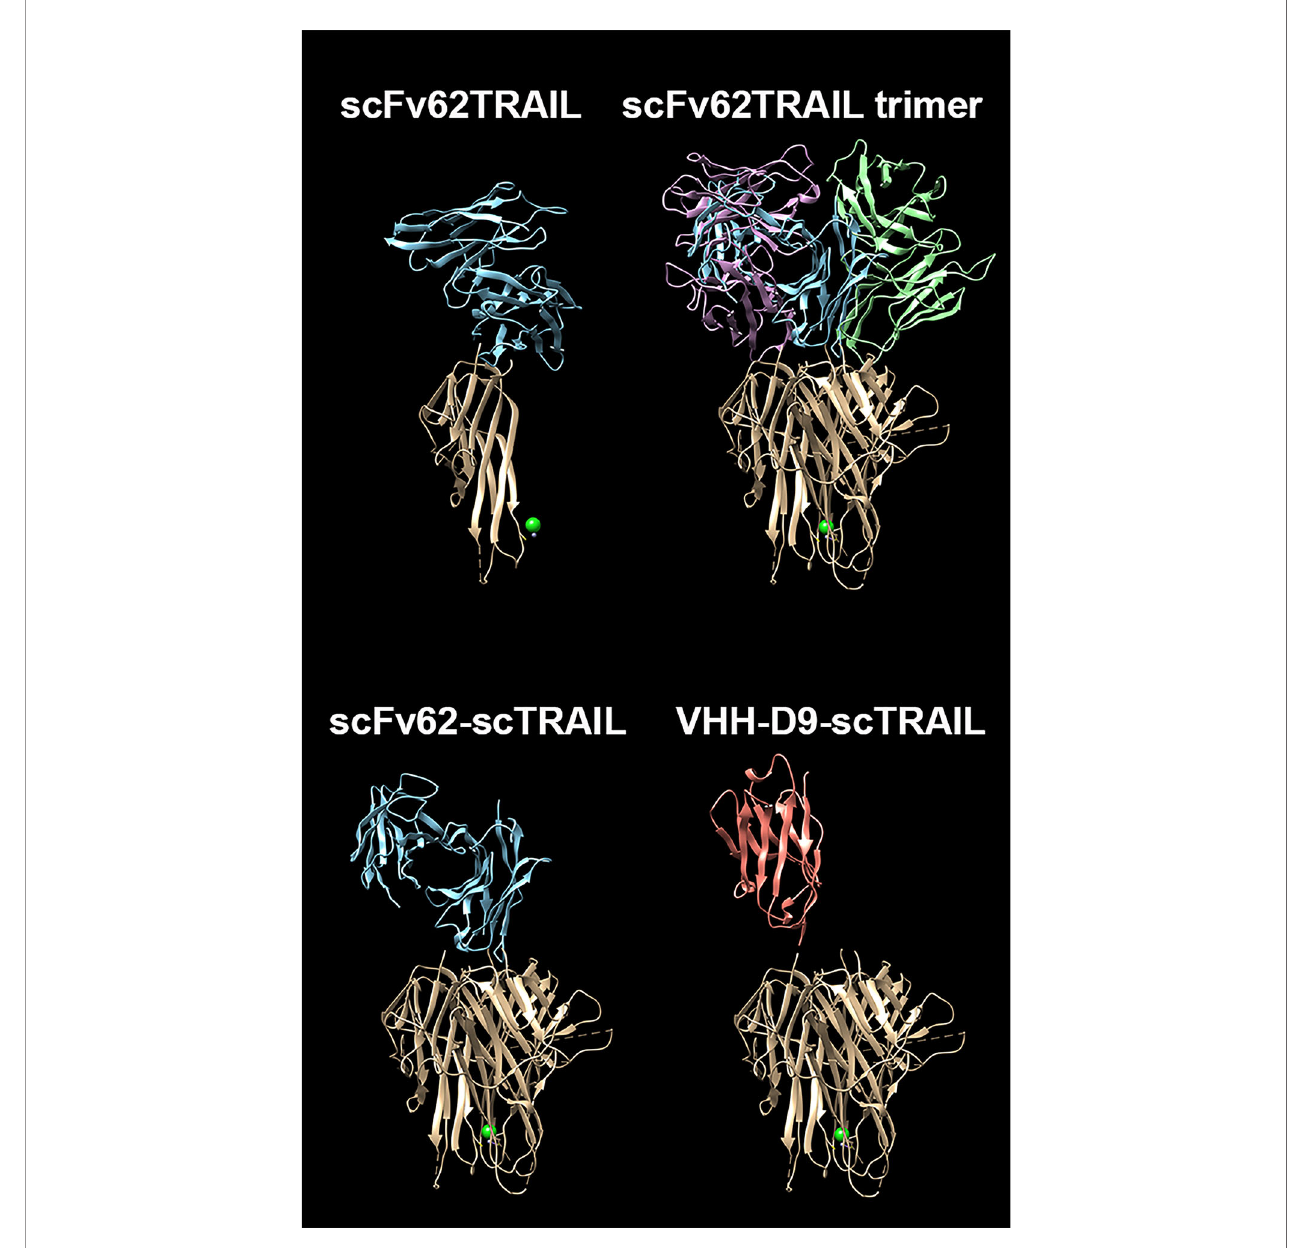
FIGURE 1 | Sequence alignment of the anti-Kv10.1 nanobodies. CDR1, 2, and 3 are underlined. Residues are colored according to chemistry. Note the strong similarity between C4 and D9, especially the conserved CDR2 and the short